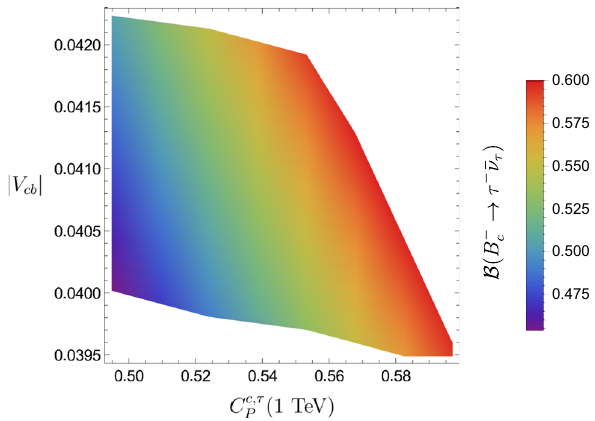
Fig. 18 Values for | V cb | and C c ,τ bound in Eq.